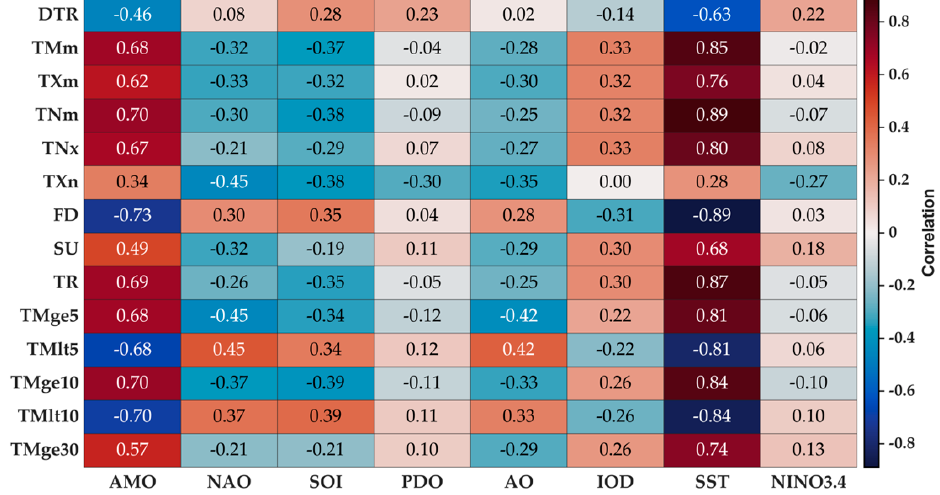
Figure 7. Correlation between temperature extremes and ocean-atmospheric circulation patterns on the annual scale over GRB from 1985 to 2014.